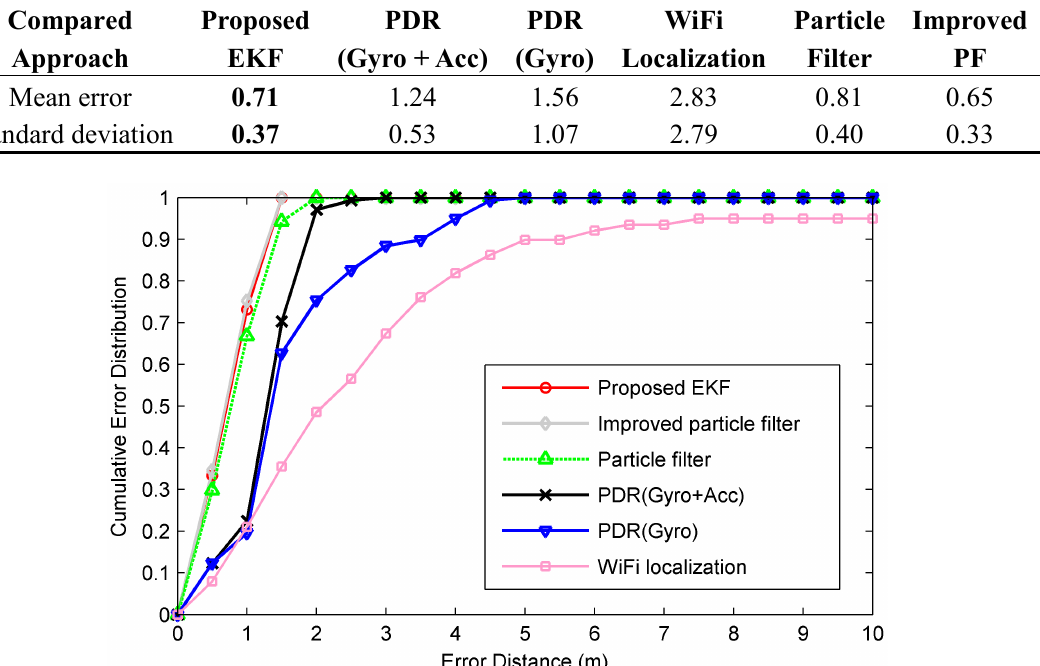
Figure 8. Accuracy comparisons between the proposed EKF based fusion approach, improved particle filter, particle filter, PDR with Gyro + Acc, PDR using gyroscope only and WiFi localization.